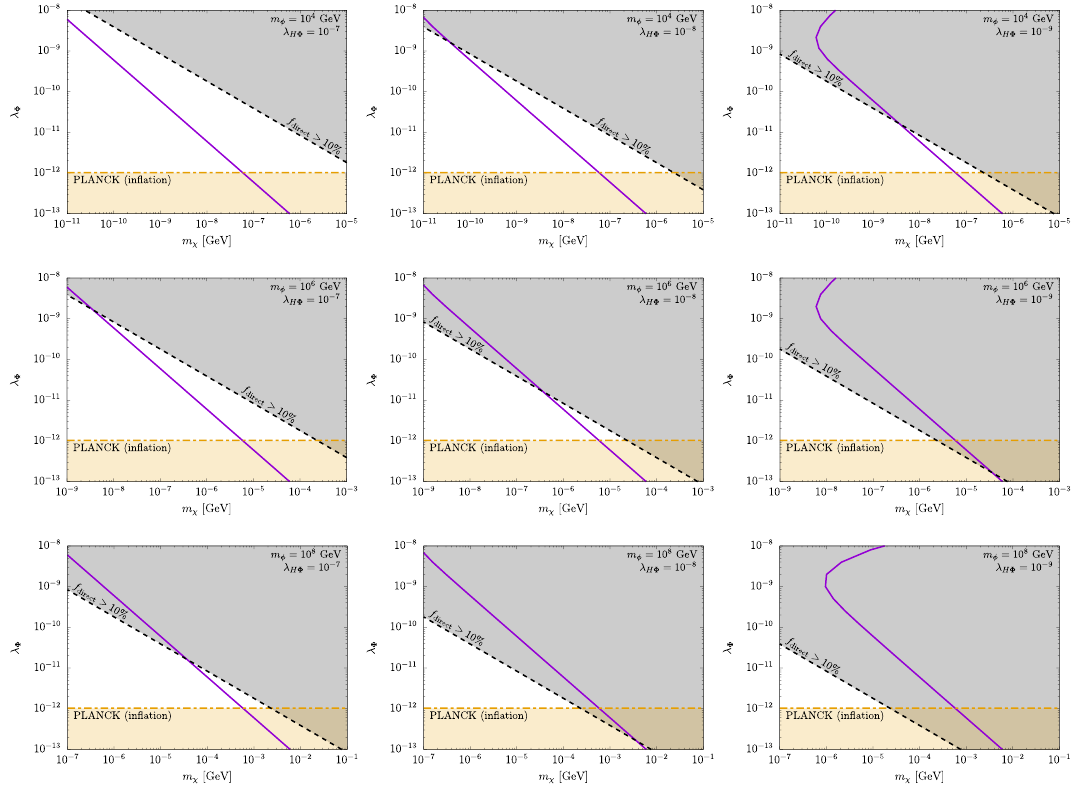
Figure 6 . Parameter space in the ( m χ , λ Φ ) plane where the reheating of the universe is assumed to occur via the perturbative inflaton decay into the SM sector. The purple lines reproduce the correct relic abundance of dark matter only by the freeze-in production. The gray regions represent the parameter space that the dark matter abundance created by the inflaton decay is larger than 10 % of the observed value. The lower orange region cannot be consistent with the inflation observables at 2 σ confidence